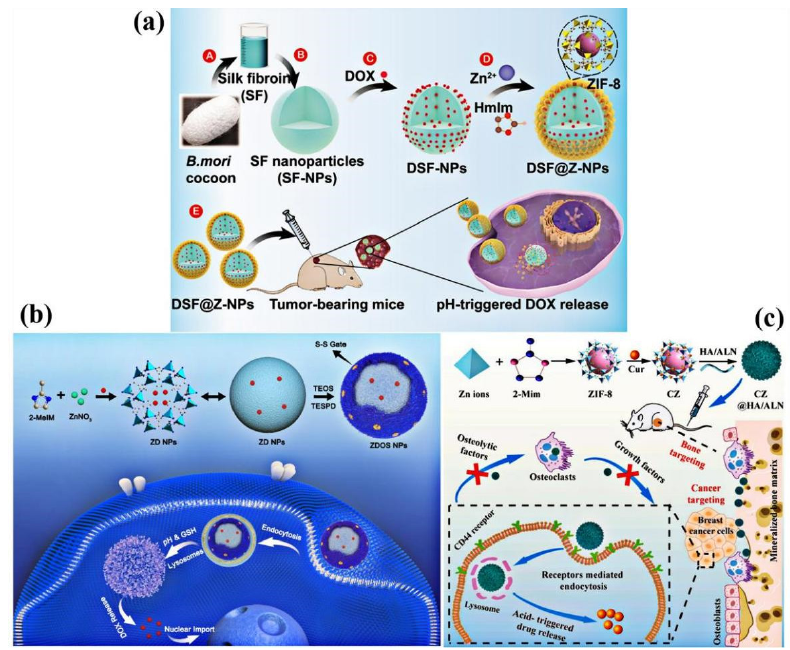
Figure 14. Schematic diagrams of the preparation of ( a ) DSF@Z-NPs, ( b ) ZIF-8@DOX@organosilica, and ( c ) CZ@HA/ALN for drug delivery. Reproduced with permission from Ref. [87], copyright (2021) the American Chemical Society, Ref. [88], copyright (2019) the American Chemical Society, and Ref. [89], copyright (2022)